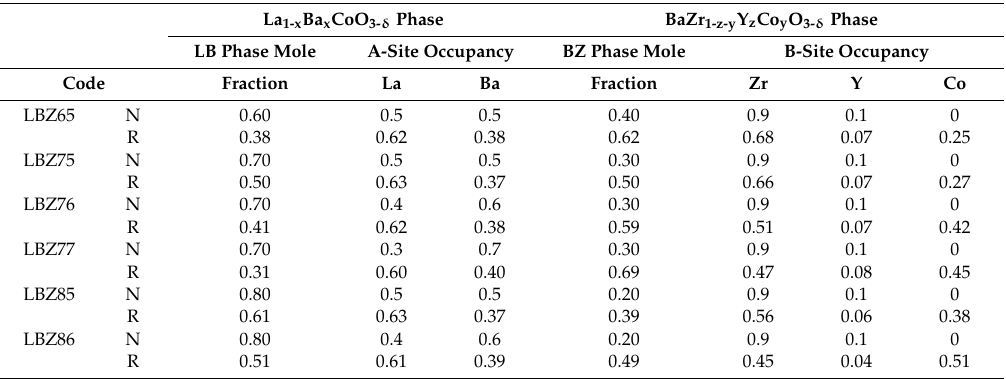
Table 2. Nominal (N) and refined (R) composite ratio, A-site occupancy in LB-phase and B-site occupancy of BZ-phase of LBZ composite cathodes. The maximum uncertainty is ± 4%.